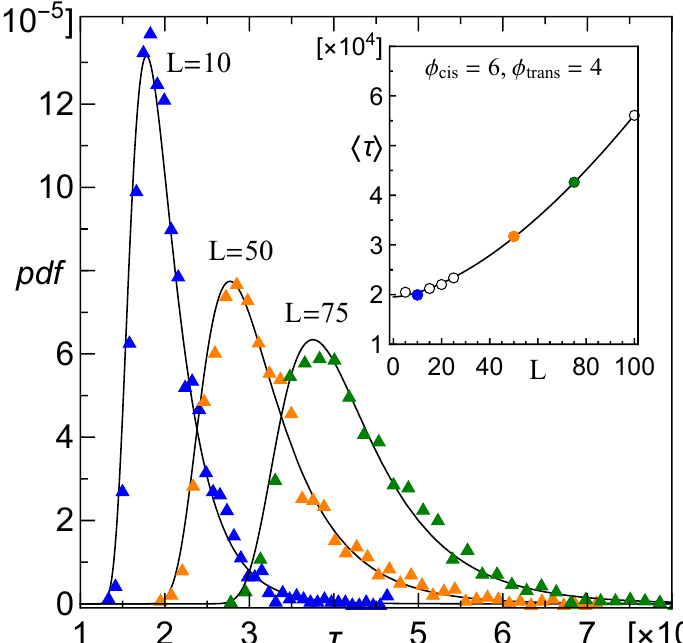
Figure 3. Empirical distributions of translocation time, τ , of a CLB with N = 100 segments computed for increasing membrane thickness, L , and pore diameters φ cis > φ trans . Solid lines follow Equation (2). The inset shows respective mean values